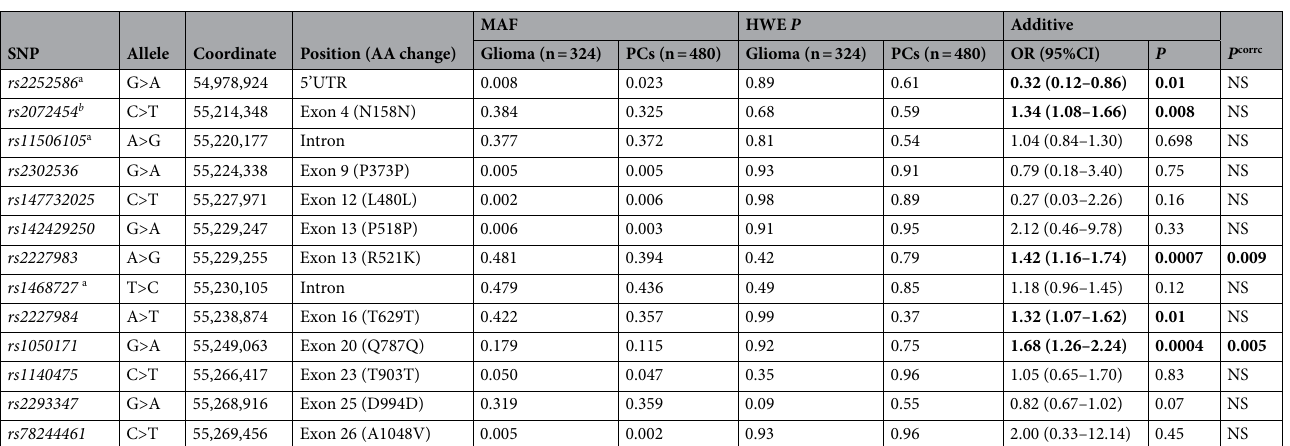
Table 2. Genotyped EGFR SNP information and association of variants with risk of glioma. Logistic regression analysis under additive model was used for calculating ORs and corresponding P -values for SNPs